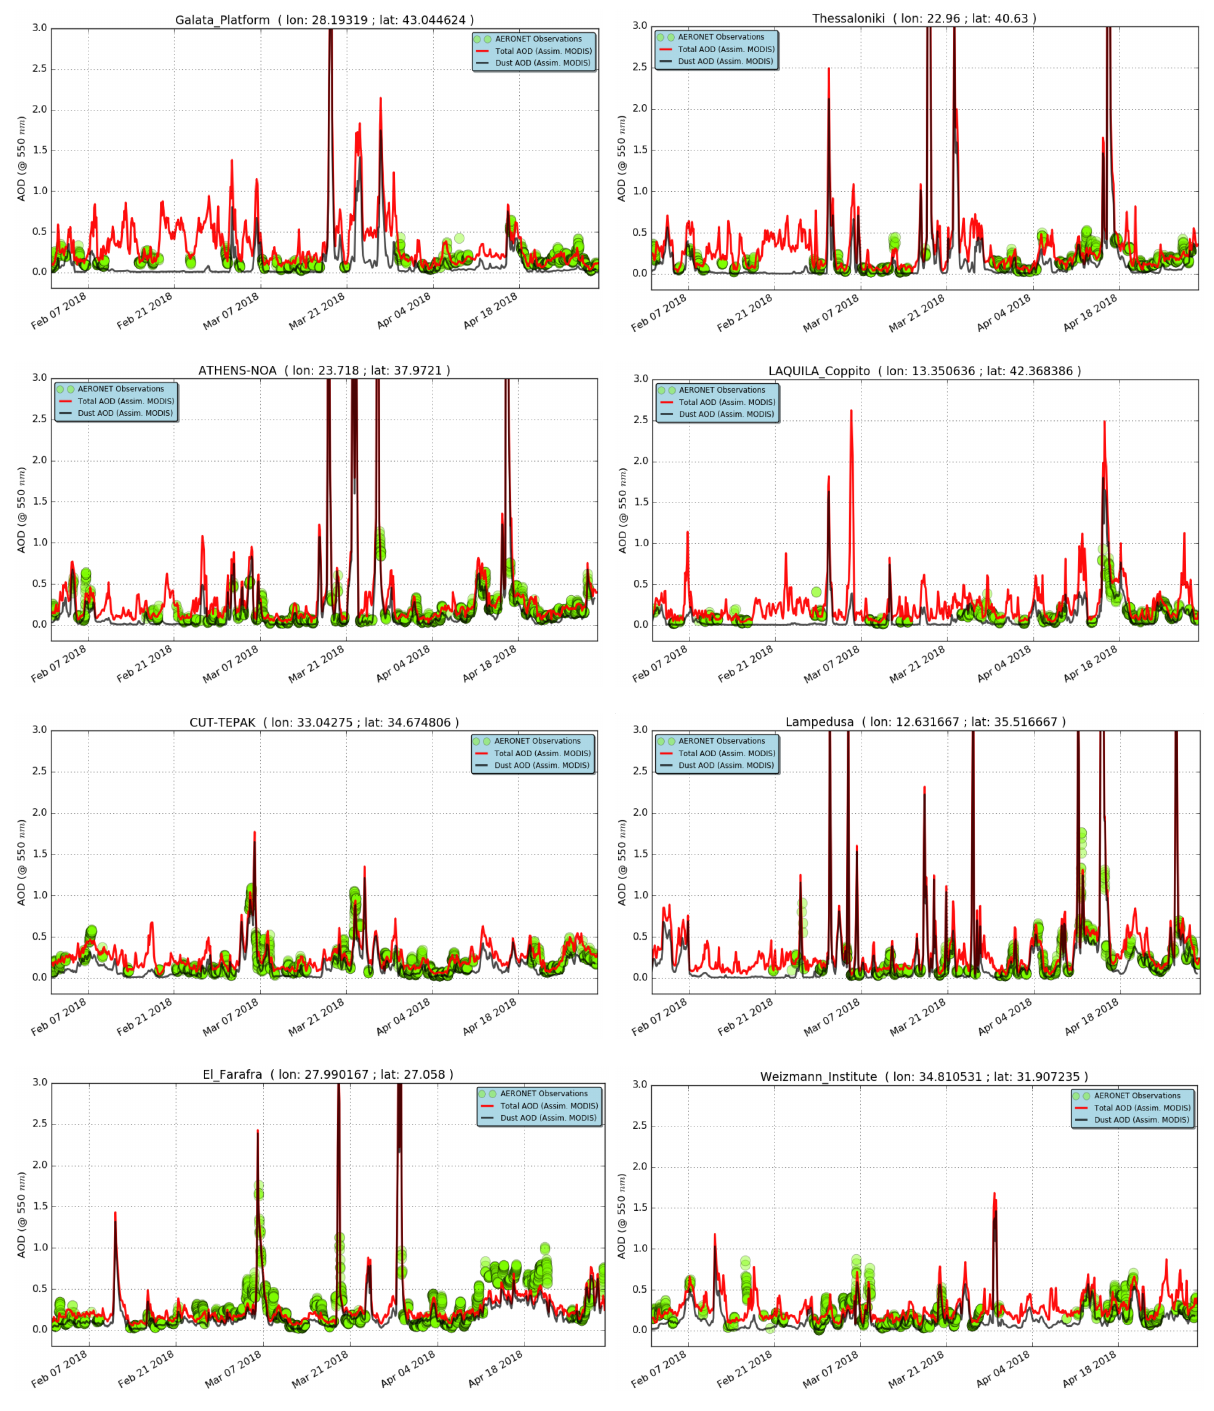
Figure 7. Time series of AOD at 550 nm of both the MODIS AOD analyses (red) compared to the AERONET in situ measurements (green circles) between 1 February 2018 and 30 April 2018. The black line corresponds to the optical depth of the desert dust. The title of each panel refers to each station’s name with its coordinates (longitude and latitude). The scores corresponding to the comparison between both datasets in terms of correlation, bias and RMSE for all the stations are presented